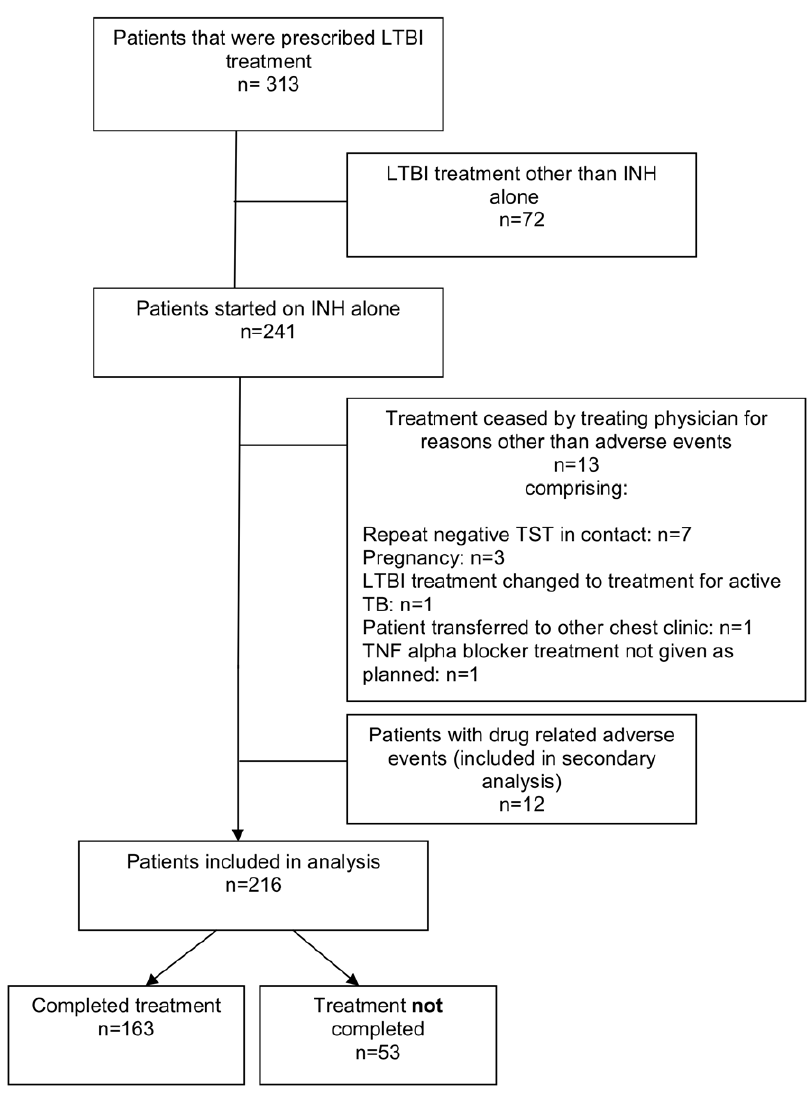
Figure 1. Flow diagram of the study population.